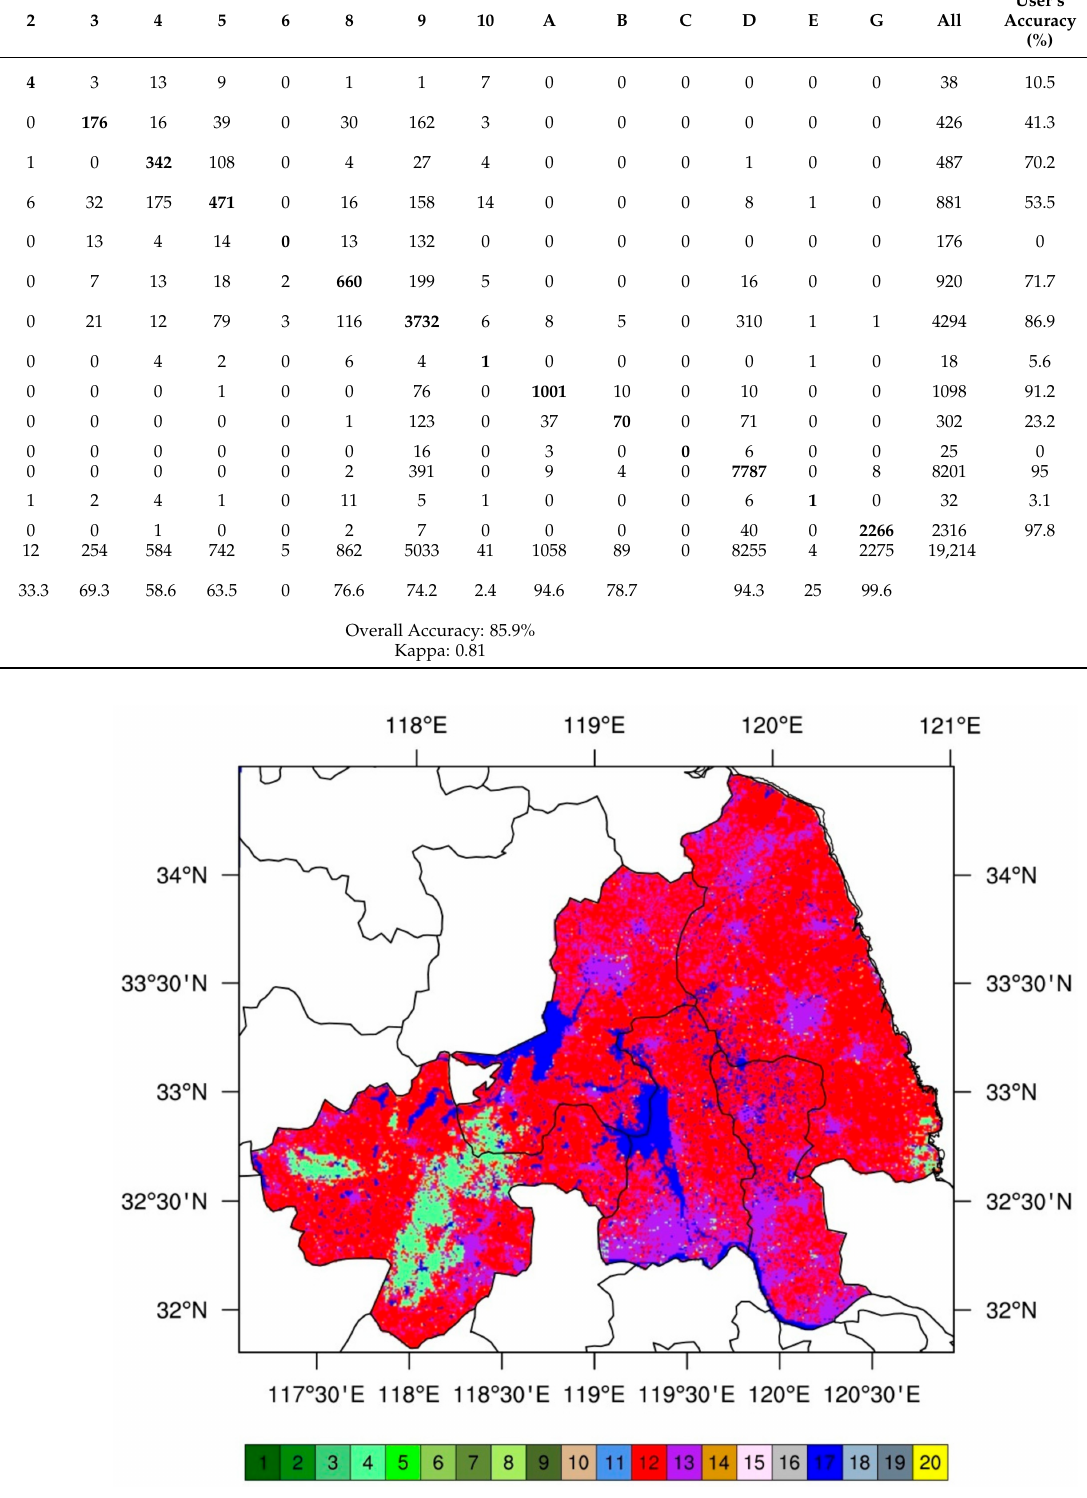
Figure 6. Land classification map based on LCZ in layer 3 simulation